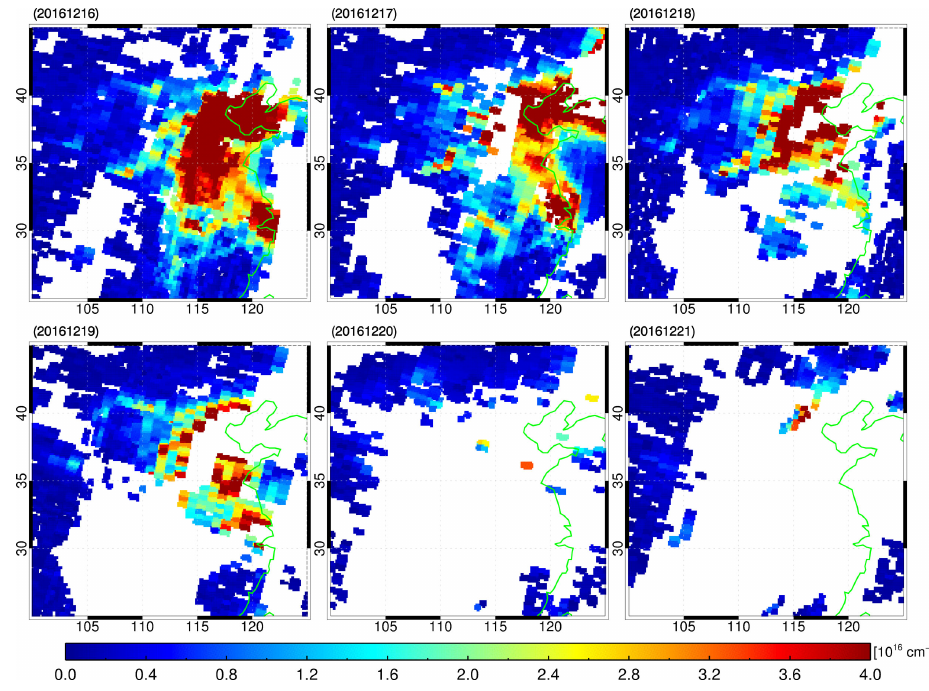
Figure 9. Same as Fig. 6 but for NO 2 from the GOME2a/GOME2b combined IUP–UB